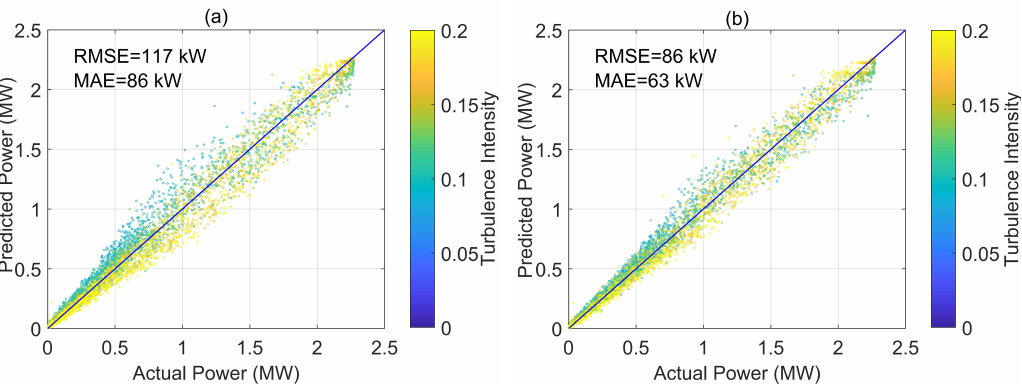
Figure 12. Performance of: ( a ) standard power curve; and ( b ) ten-minute version of the model, considering an optimum value for reference density ( ρ 0 = 1.19 kg · m − 3